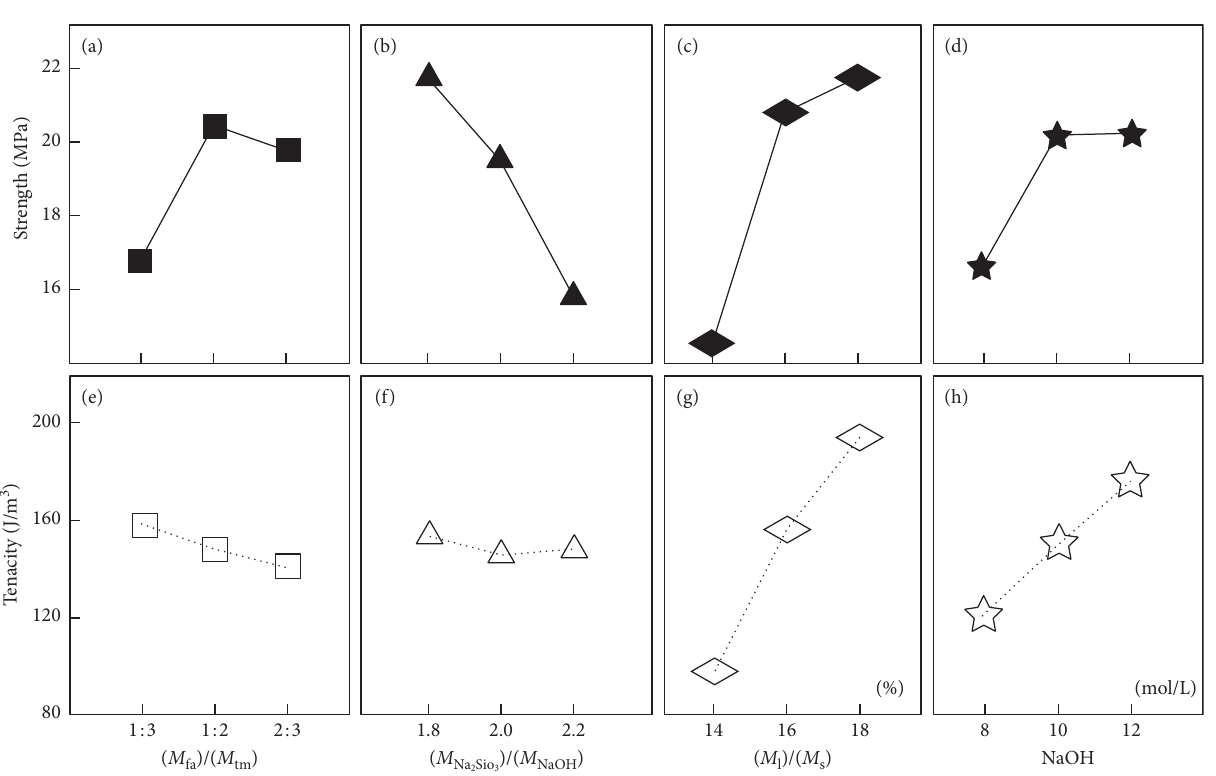
Figure 4: The strength and tenacity affected by each